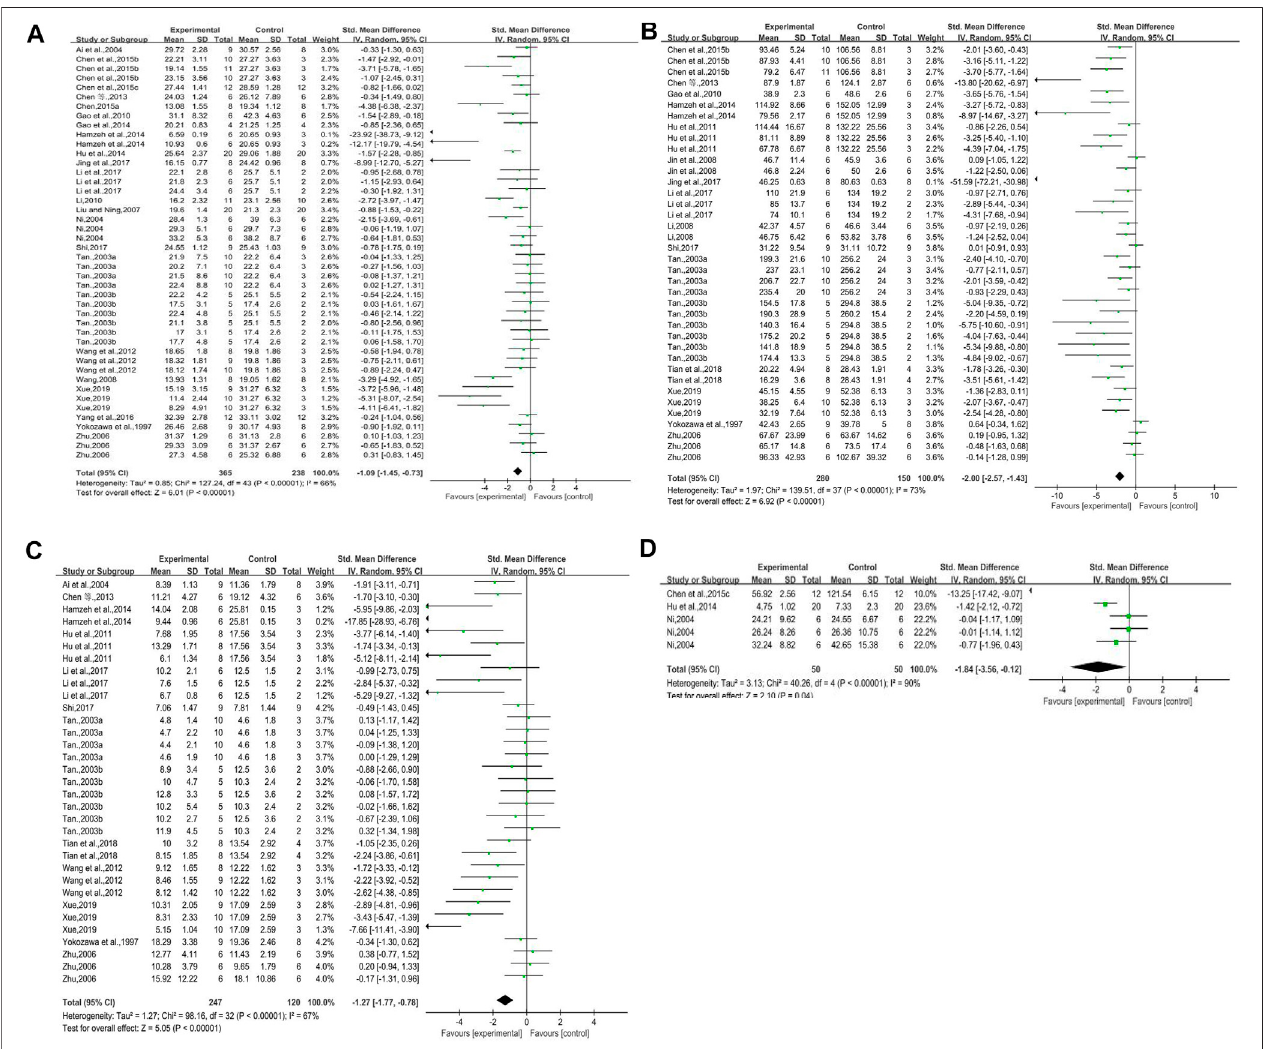
FIGURE 3 | (A) Forest plot of blood glucose, (B) forest plot of Scr, (C) forest plot of BUN, and (D) forest plot of ACR.